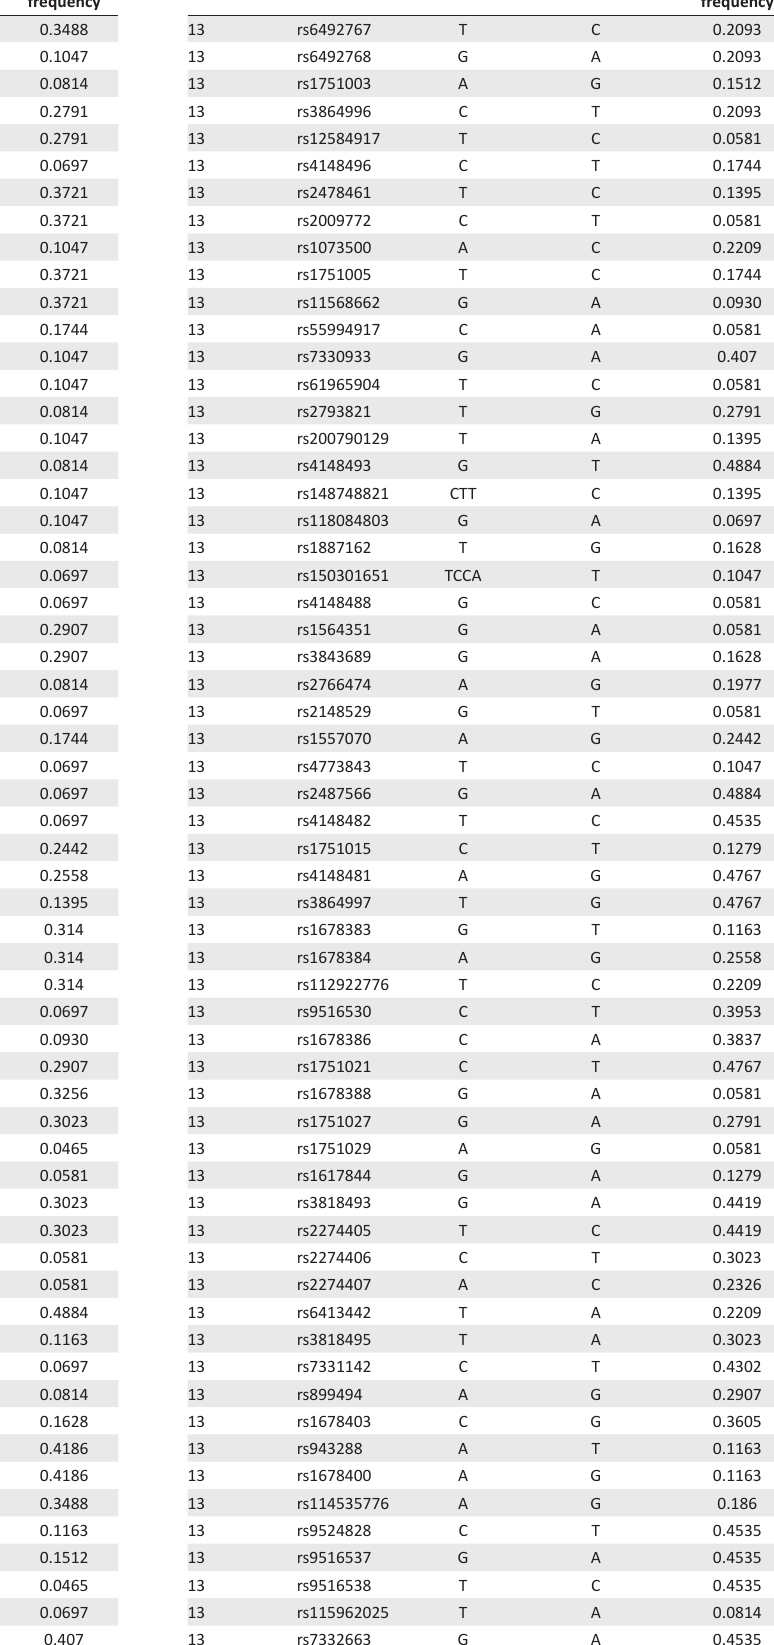
Table 1-A1 (Continues...): Minor allele frequencies for 1846 polymorphisms in 43 black South Africans. Chromosome Polymorphism Minor allele Major allele